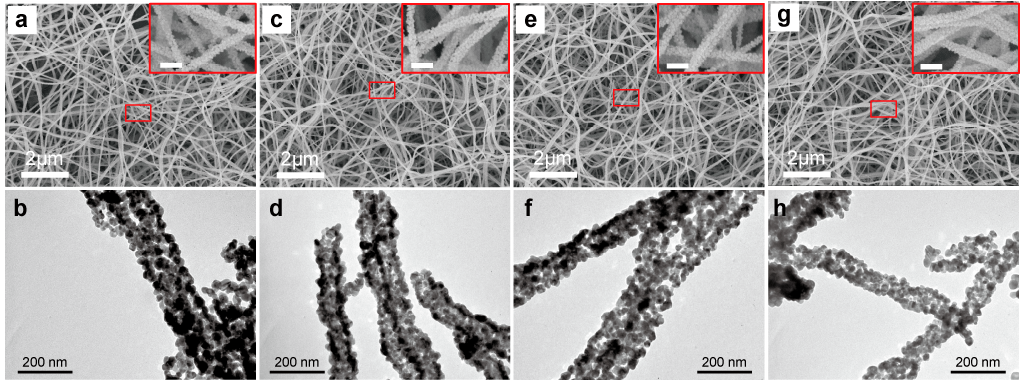
Figure 1. Scanning electron microscope images ( a , c , e , g ) and transmission electron microscope images ( b , d , f , h ) images of ( a , b ) pristine SnO 2 porous nanofibers as well as ( c , d ) 1.0 wt %, ( e , f ) 4.0 wt %, ( g , h ) 8.0 wt % Li + -doped SnO 2 porous nanofibers prepared by electrospinning and post-calcination at 600 °C in air for 5 h. The insets are high-resolution SEM images (Scale bar: 200 nm). The pristine SnO 2 porous nanofibers and Li + -doped SnO 2 porous nanofibers showed a porous structure. The Li + -doped SnO 2 porous nanofibers can be controlled by changing the ratio of lithium chloride hydrate in precursors.